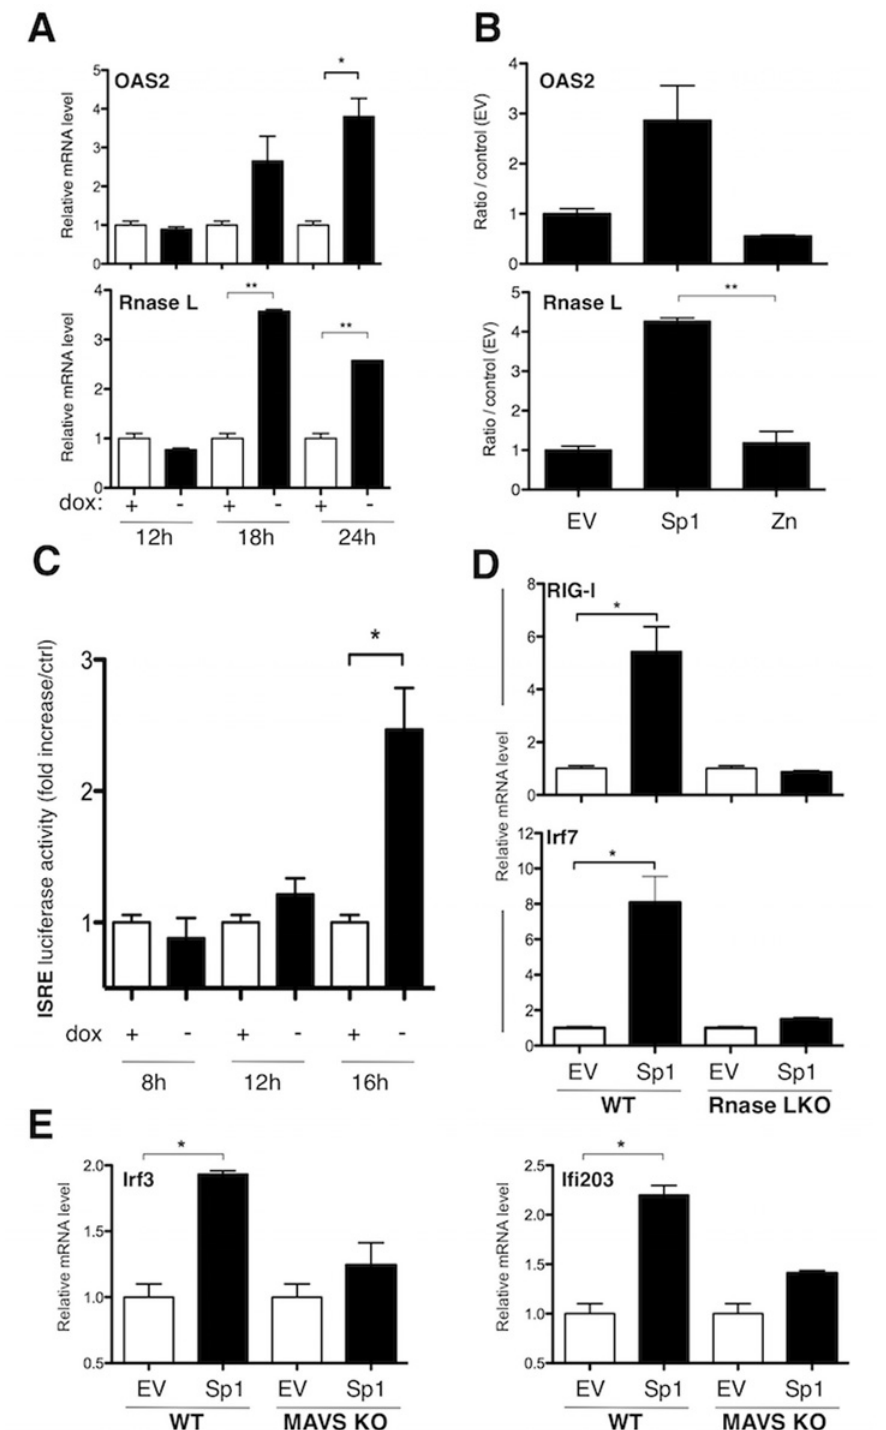
Fig 4. Sp1 activates the OAS-RNAse L pathway and the production of small self-RNAs. (A) BaF3-Sp1 inducible cell line was grown with (white bars) or without (black bars) dox for the indicated times, and relative mRNA levels of OAS2 and RNase L genes were quantified by RT-qPCR. (B, D, E) 3T3 (B) and MEFs (D, E) WT or deficient for the RNase L (RNase L KO) or MAVS (MAVS KO) were transduced with Sp1, Sp1 Zn 2,3 (Zn) or empty vector (EV). Transduced cells (CD2 positive) were purified 72 h post-transduction by magnetic